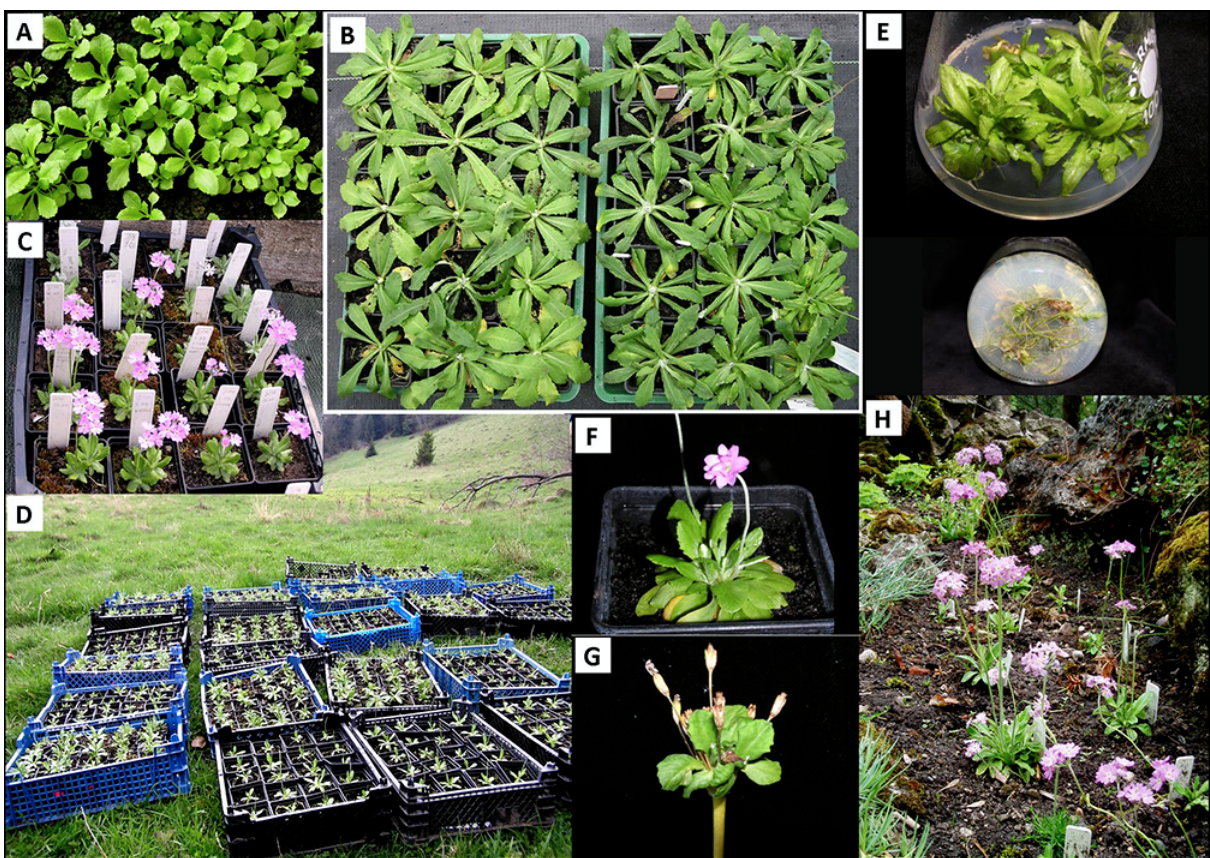
Figure 1 Ex situ propagation of Primula farinosa : seed-derived plants ( A,C,D ) and left side in ( B ) and micropropagated plants ( E– H ) and right side of ( B ). ( A ) Six-week-old seedlings after cultivation in growth chamber. ( B ) Comparison of seed-derived (left side) and in vitro-derived (right side) plants at the end of first year of cultivation in open air collection. ( C ) Blooming seed-derived plants inthe second year of cultivation in the collection. ( D ) Seed-derived plants before planting on the secondary locality (2016). ( E ) − 3 Rooting shoots after 5 weeks of cultivation on MS medium supplemented with 0.1 mg dm IBA. ( F,G ) Transient abnormalities of generative organs in the year of acclimatization of in vitro-derived plants: altered morphology of corolla of flowers ( F ); gemmae within inflorescence ( G ). ( H ) In vitro-derived plants in the collection of the Botanical Garden in Krakow